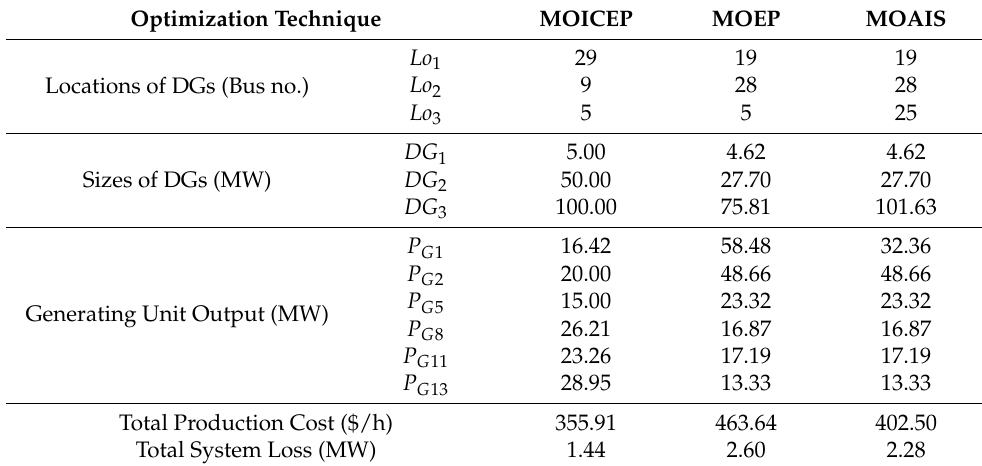
Table 2. Results of the integrated basic ED and DG installation of the IEEE 30-Bus RTS ( w 1 = 0.9 and w 2 = 0.1).